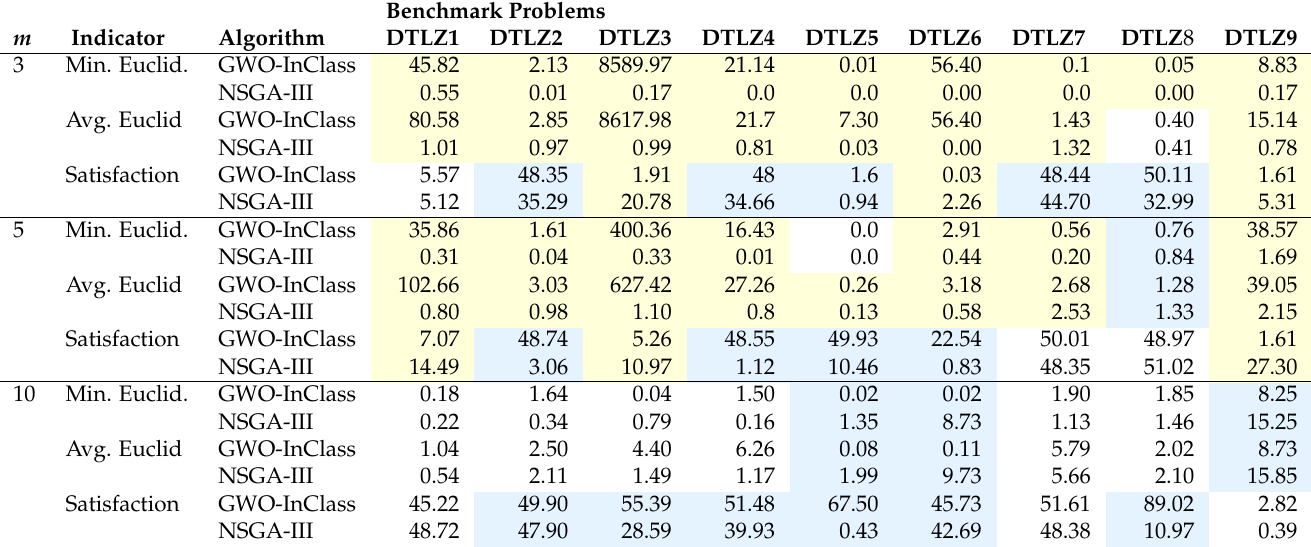
Table 2. Average results obtained by GWO-InClass and NSGA-III. Benchmark